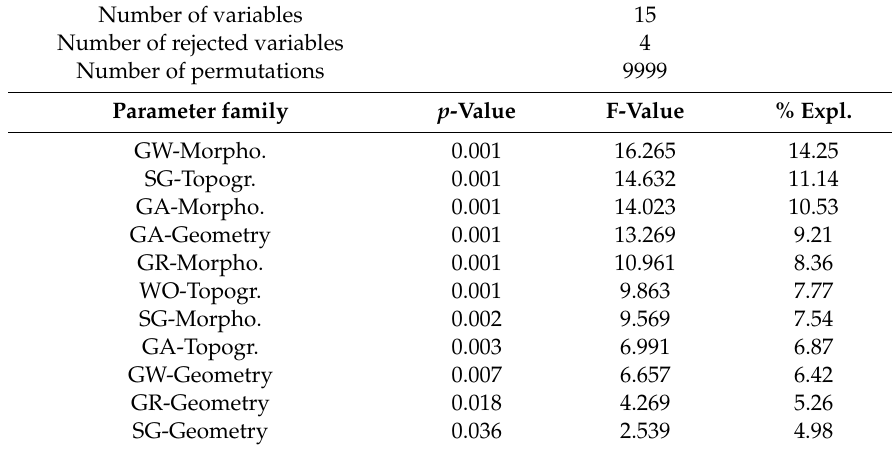
GW-Morpho.—Green walls-morphological parameters; SG-Topogr.—Greenery along the streets-topographic parameters; GA-Morpho.—Green areas-morphological parameters; GA-Geometry—Green areas-geometrical parameters; GR-Morpho.—Green roofs-morphological parameters; WO-Topogr.—Water structures-topographic parameters;SG-Morpho.—Greeneryalongthestreets-morphologicalparameters;GA-Topogr.—Greenareas-topographic